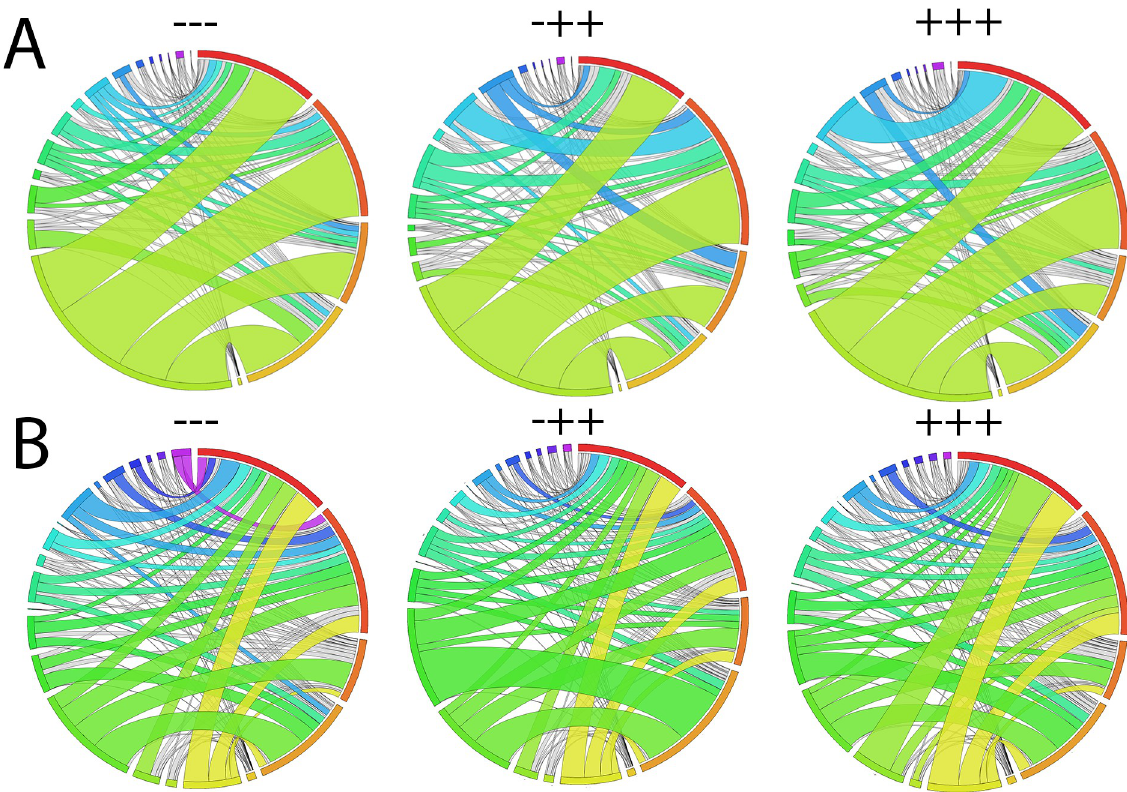
Fig 9. Circos Plots of V/J combinations by Treatment Group of Immunoglobulin Heavy Chain (A) and kappa (B) Chain. Mice treated with saline (—), TT+CpG (-++) or AOS+TT+CpG (+++). Each band represents a V/J pairing with more common V/J pairings being colored and having wider bands. Circos plot labels (starting at 12:00 position proceeding clockwise with occasional color references for reader orientation) (A) J1 (red), J2, J3, J4, U (yellow), V1, V2, V3, V4, V5, V6, V7 (Teal), V8, V9, V10, V11, V12, V13, V14 (purple), V15 (B) J1 (red), J2, J4, J5, U, V1 (yellow), V2, V3, V4, V5, V6, V7 (black sliver), V8, V9, V10, V11, V12, V13, V14, V15 (royal blue), V16, V17, V18, V19, V20 (black sliver, if present).